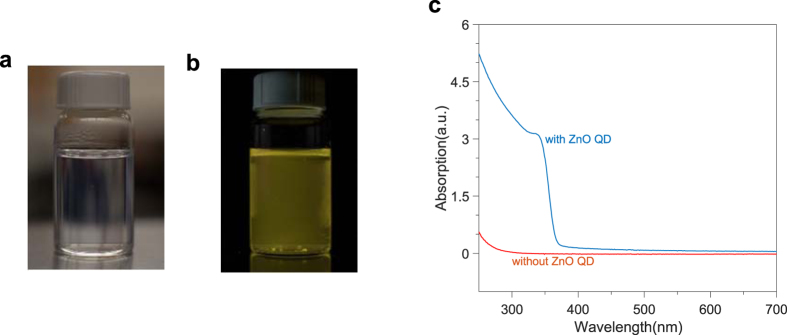
Ultrathin QD-nanocellulose paper precursor.Photos of ZnO QD-nanocellulose composites in water under room light (translucent) (a) and under 365 nm UV excitation (b). (c) UV-vis absorption measurement results of the nanocellulose thin films on glass slides with (blue curve) and without (red curve) ZnO QDs. The discrepancy between the two curves at longer wavelengths (>370 nm) is possibly due to light scattering, which comes from slightly increased inhomogeneous nanocellulose distribution on the glass slide when QDs are present.